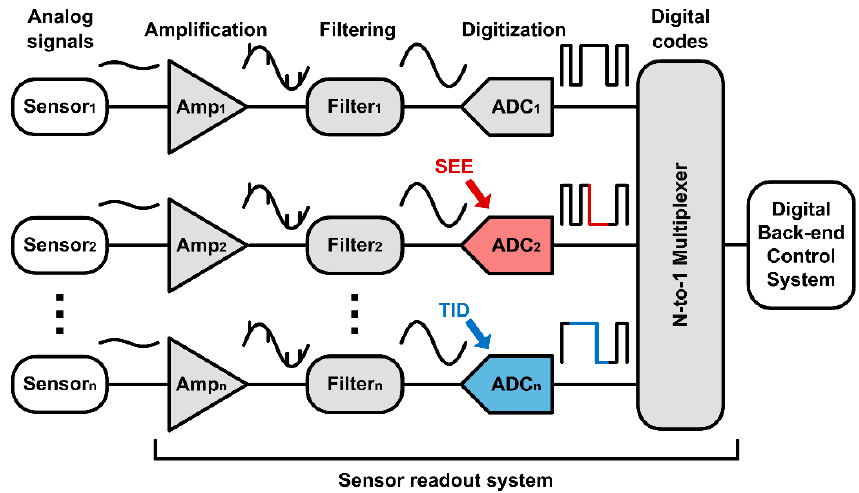
Figure 1. Block diagram of the sensor front-end readout system in radiation environments.